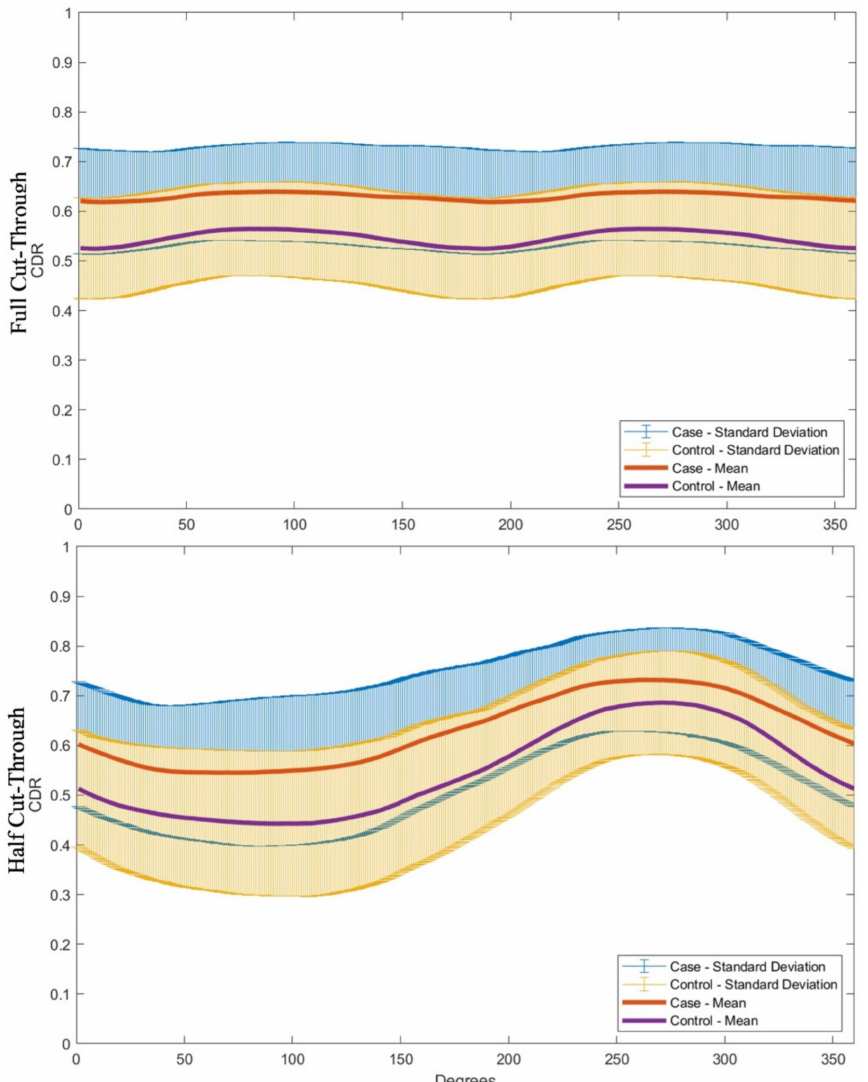
Figure 4. Comparison of the mean (and standard deviation) of full and half cut-through measure- ments between the case (N = 845) and control (N = 244) cohorts in Bins 2–8. Measurements include both OD and OS eyes from each bin, with the measurements from the OS eyes horizontally inverted to match the OD nasal/temporal